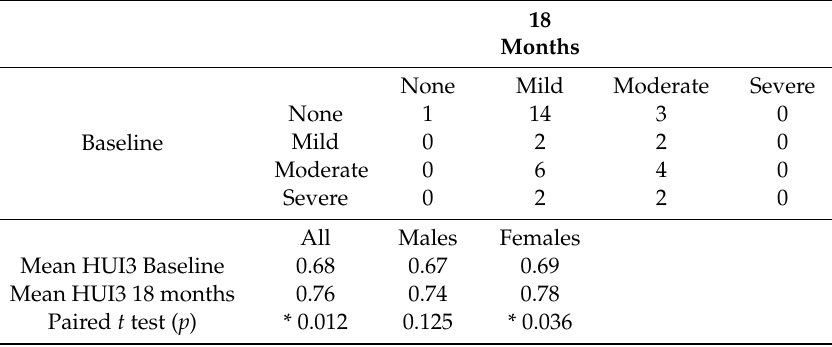
Table 14. Changes in the Health Utilities Index-3 (HUI-3) quality of life from baseline to 18 months after hearing aid fitting ( n =